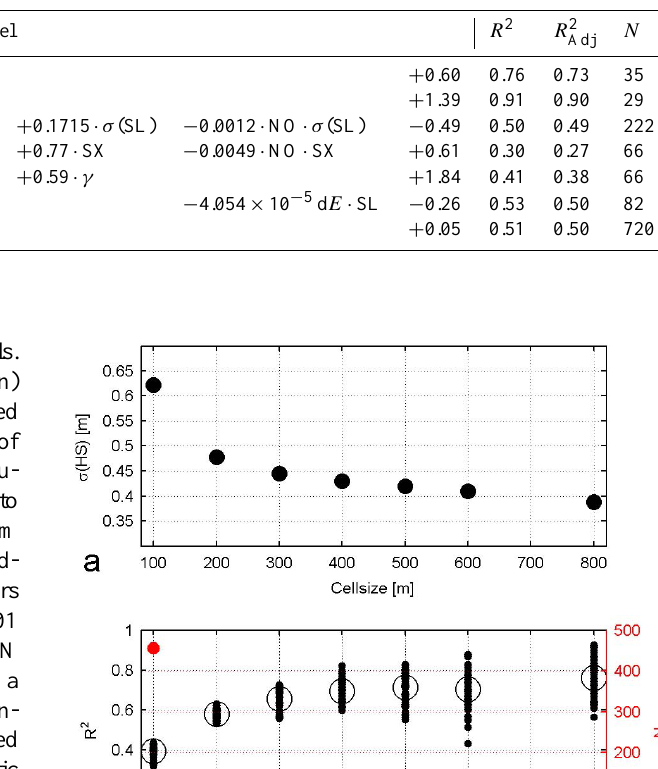
Table 2. Best two- to three-parameter model for each single investigation area, where dHS and d E are in metres and SL and NO in degree. Column 3 to 5 show the R 2 , the adjusted R 2 ( R 2 ) and the number of sub-areas for each model. For HEF all data (four points of time) were Adj combined to one single model.